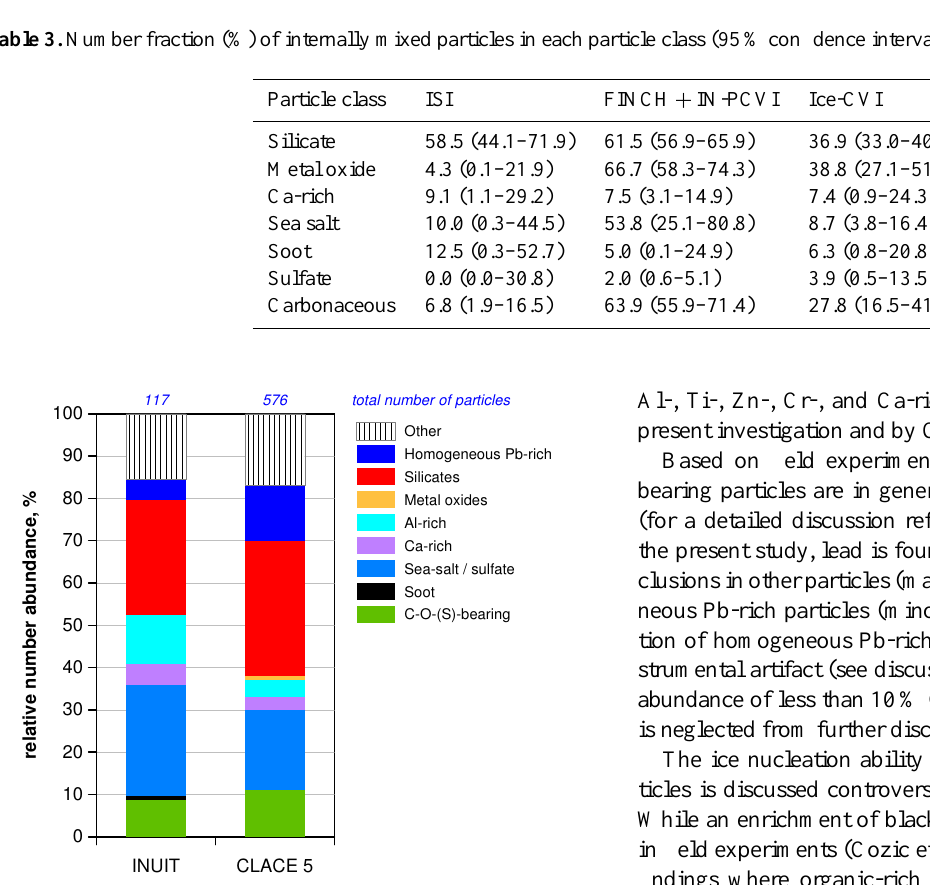
Figure 9. Comparison of the composition/mixing state of Pb- bearing particles from INUIT (present contribution) and CLACE 5 (Ebert et al., 2011) from the Ice-CVI. Note that classification crite- ria and nomenclature of Ebert et al. (2011) were used for this graph. For confidence intervals see Table S5 in the